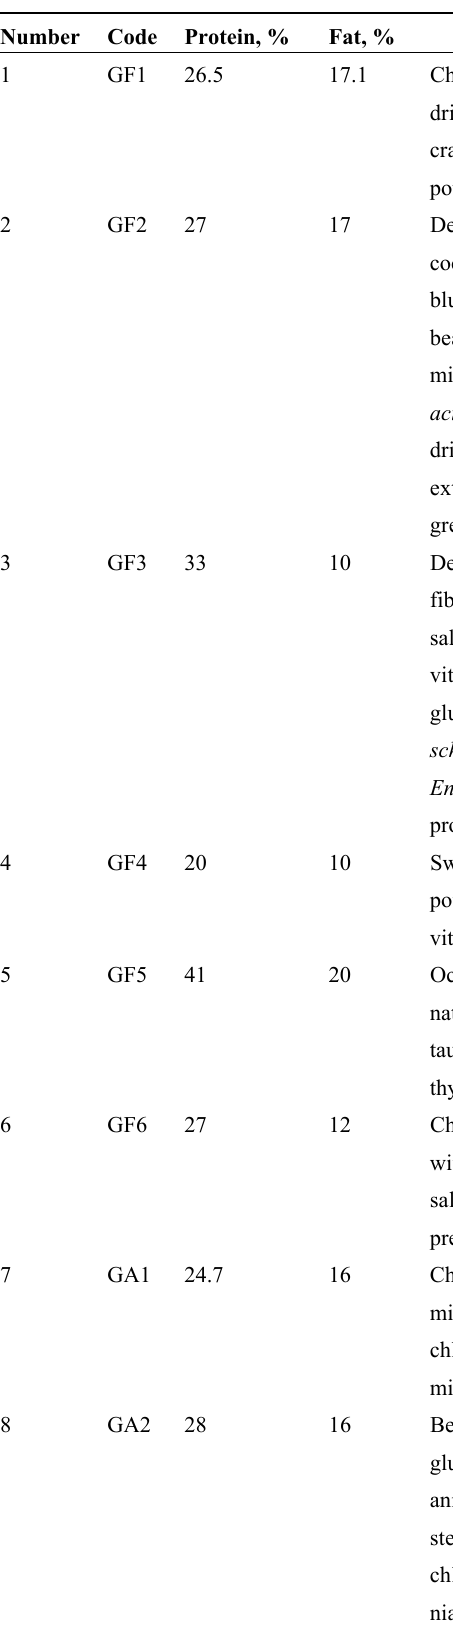
Table 3. Sample codes, nutrient contents, and